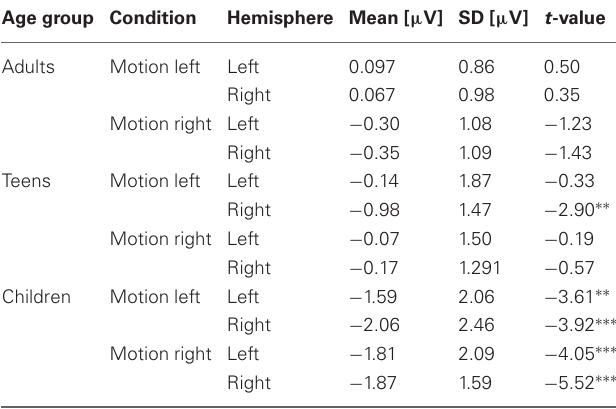
Table 3 | MMN (small deviant) for adults, teens, and children: amplitudes und